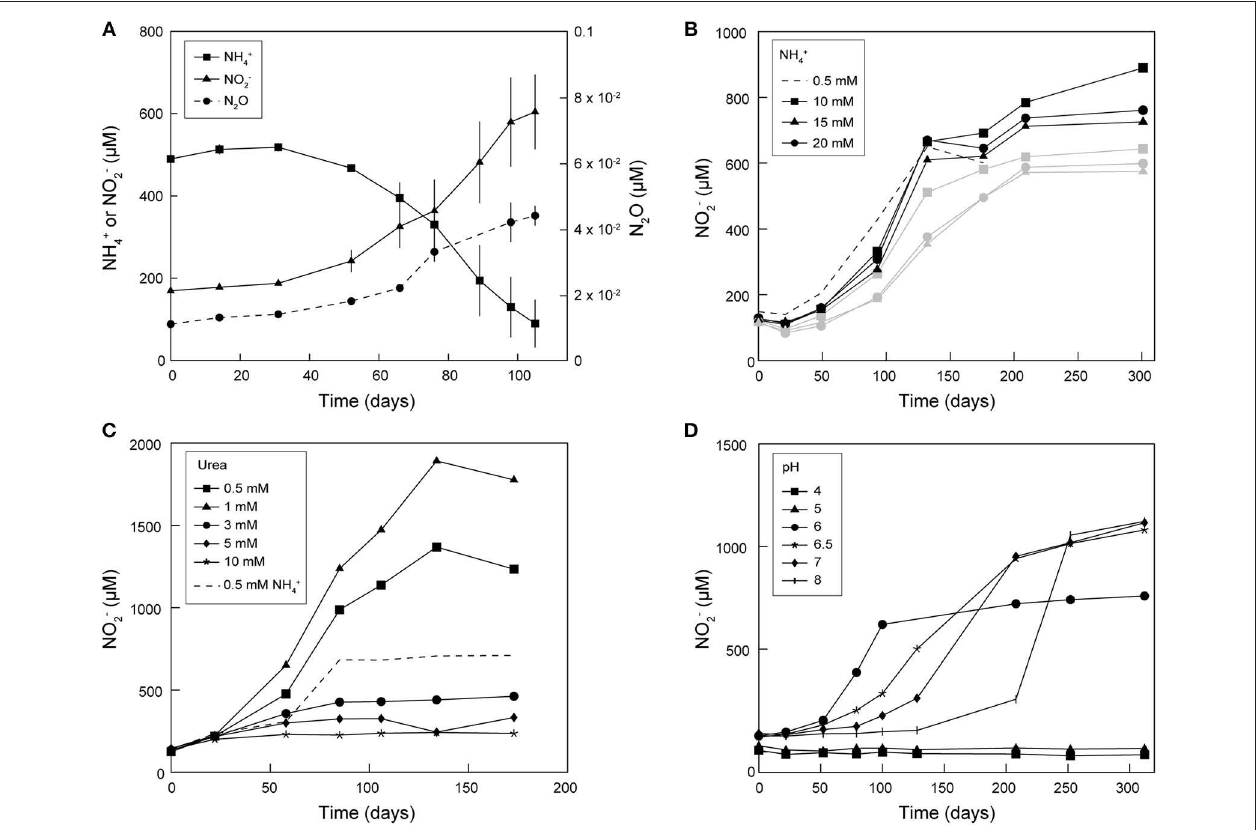
FIGURE 1 | Enrichment cultures of Ca. N. arcticu s Kfb grown at 20 ◦ C under different conditions. (A) Cumulative net NH + 4 consumption, and net NO − 2 and N 2 O production in triplicate cultures. Error bars represent standard deviations. (B–D) Cumulative net NO − 2 production in enrichment cultures of Ca. N. arcticus Kfb under (B) different initial NH + 4 concentrations (black and gray lines represent cultures deriving from two distinct inocula, respectively), (C) different initial urea concentrations, and (D) different initial pH.